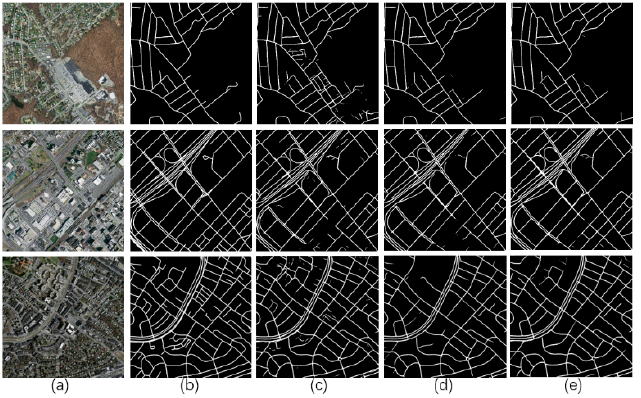
Figure 13. Results in the complicated scenes: ( a ) original image; ( b ) label; ( c ) D-LinkNet; ( d ) DenseNet (k = 24) + stem block; ( e ) D-DenseNet (k = 24) + stem block + D-Block.